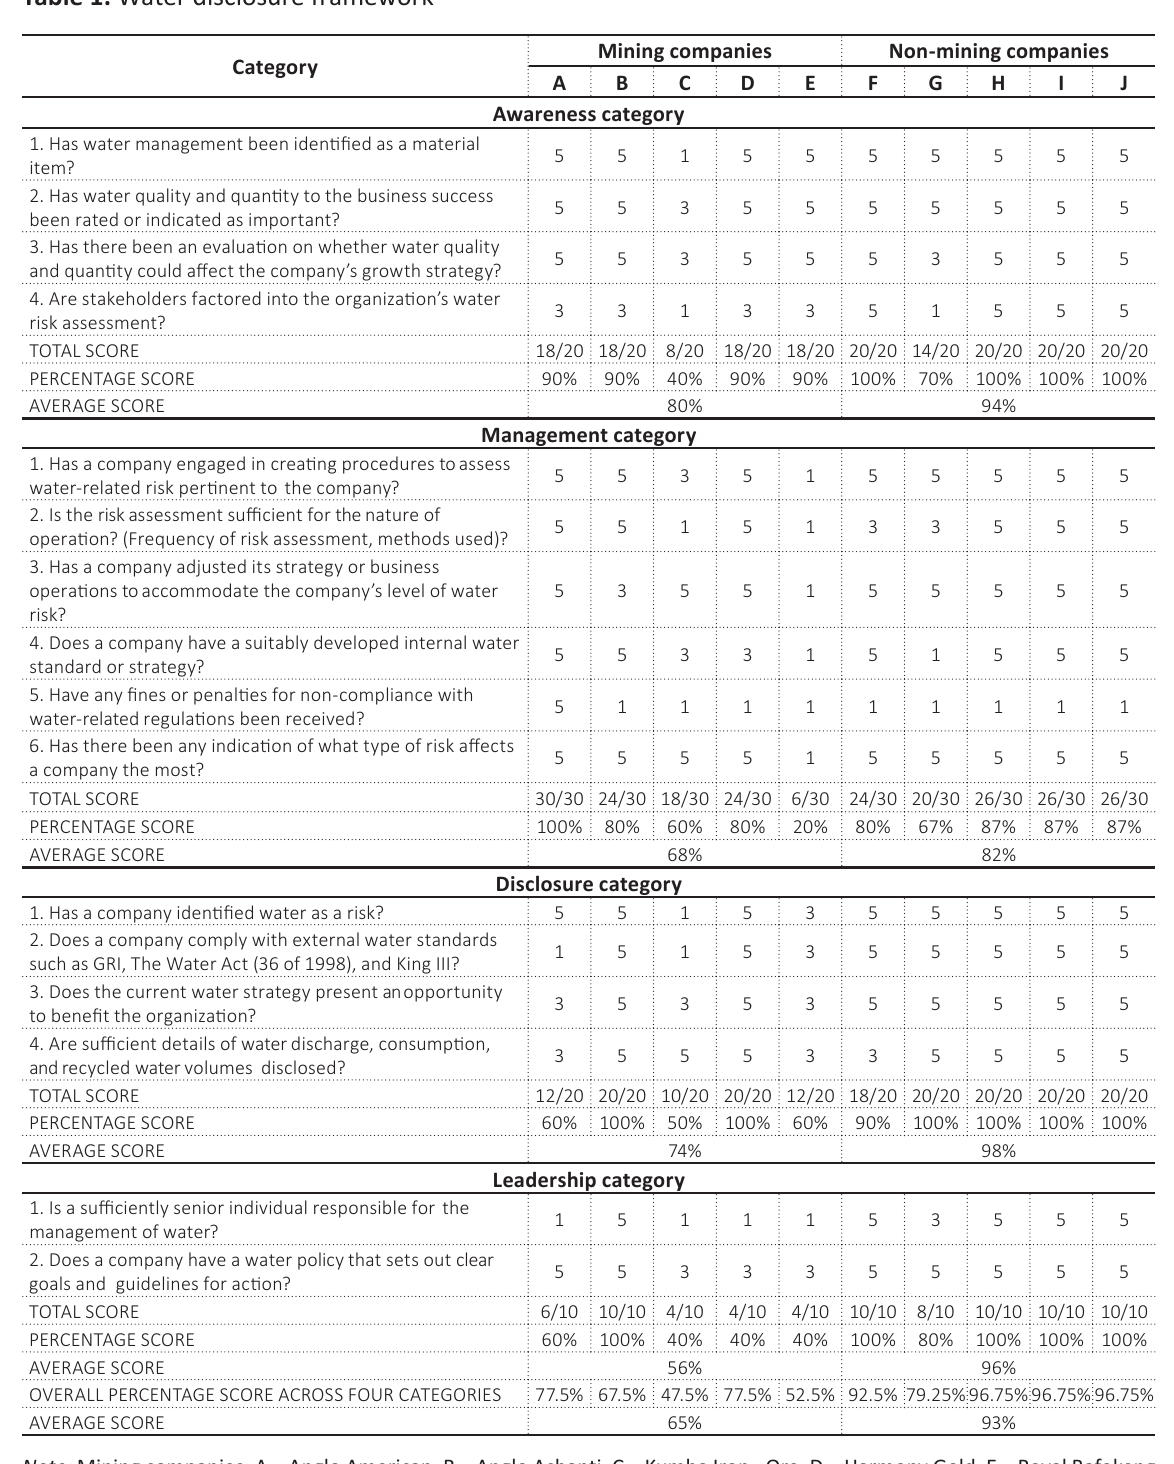
Table 1. Water disclosure